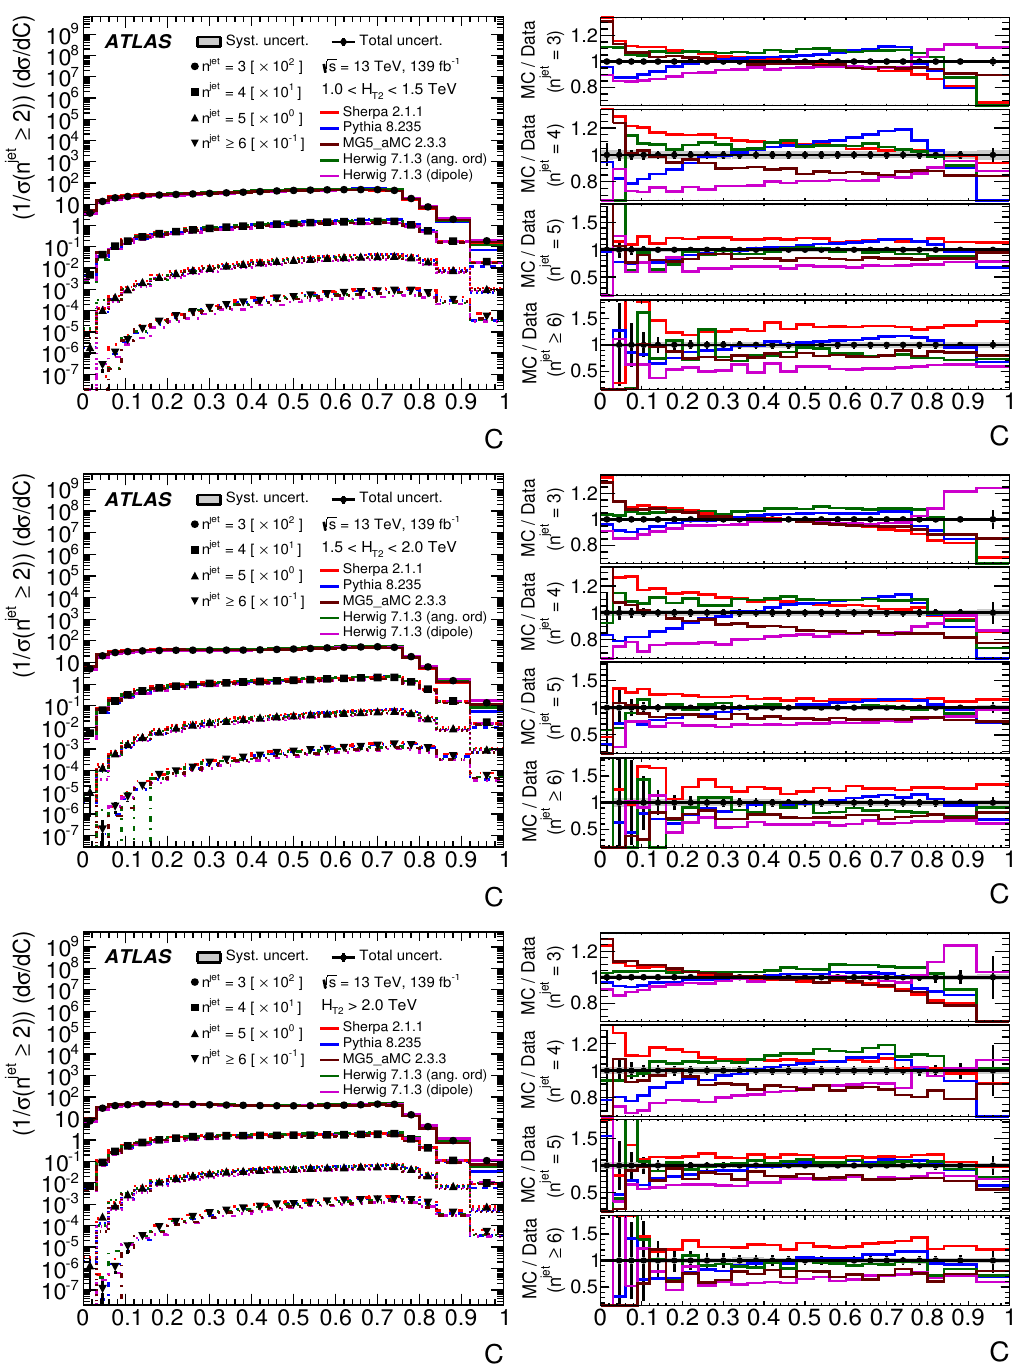
Figure 9 . Comparison between data and MC predictions as a function of C (see eq. 3.5) for different jet multiplicities and energy scales. For illustration purposes, the corresponding differential cross section for each jet multiplicity is multiplied by 10 2 ( n jet = 3), 10 1 ( n jet = 4), 10 0 ( n jet = 5), 10 − 1 ( n jet ≥ 6). The right panels show the ratios between the MC and the data distributions. The error bars show the total uncertainty (statistical and systematic added in quadrature) and the grey bands in the right panels show the systematic